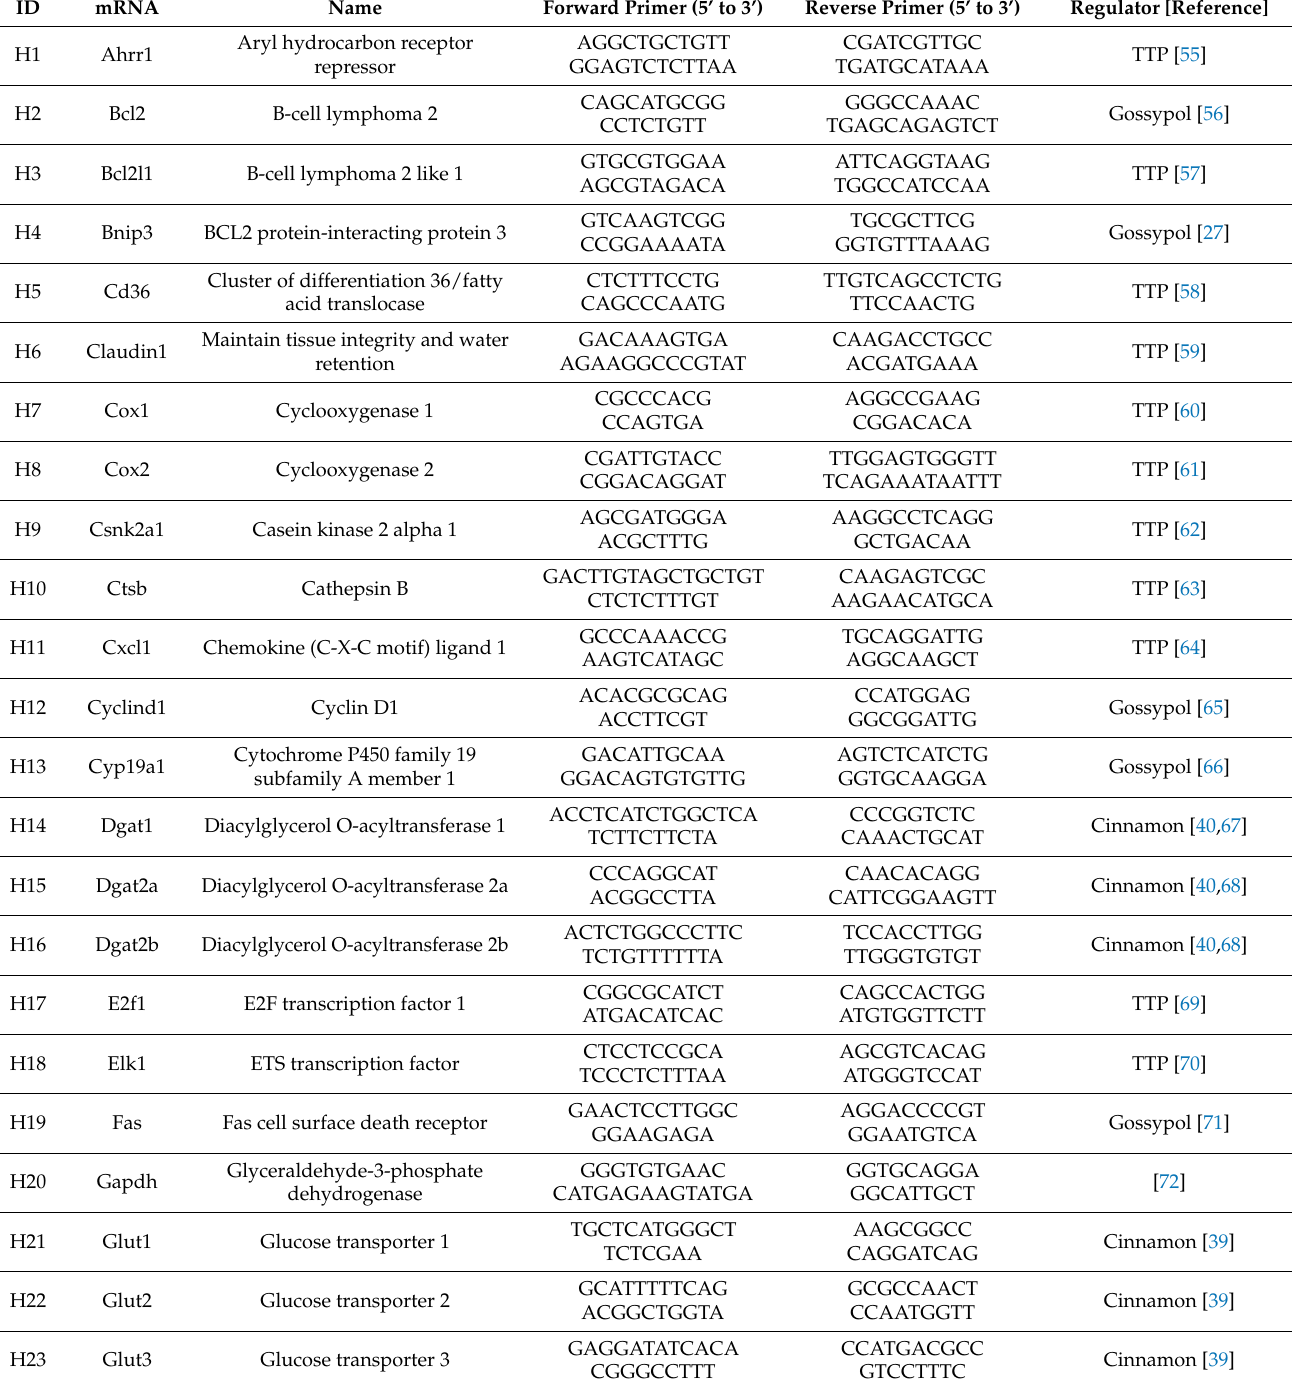
Table 1. Human mRNA targets analyzed by qPCR; these genes are regulated by TTP, plant toxin gossypol, and plant nutrient cinnamon extract as indicated in the